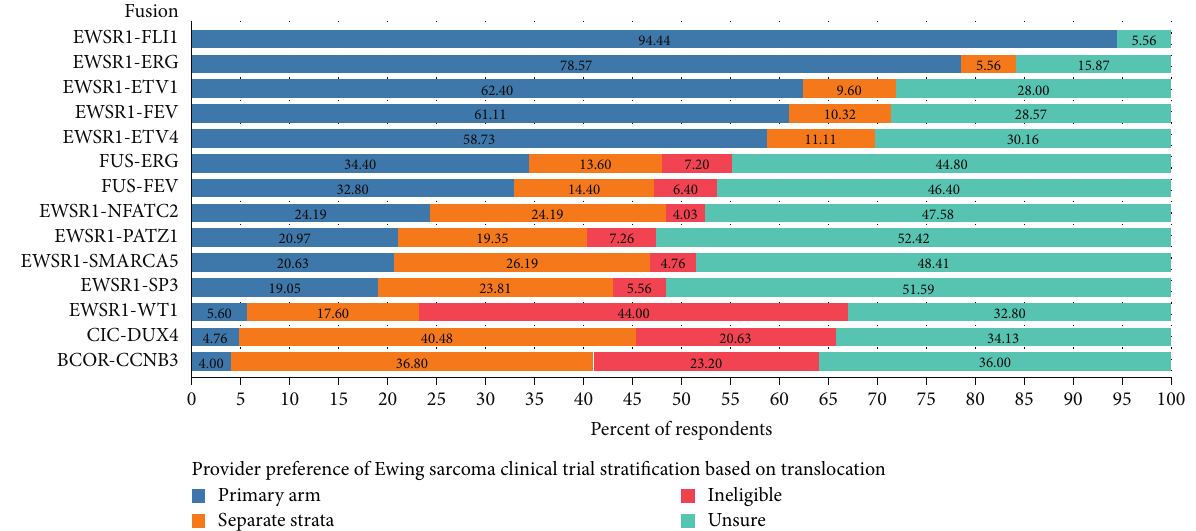
Figure 3: Perceptions of respondents on the optimal stratification of variant chromosomal translocations on future Ewing sarcoma clinical trials. The data represent the percentage of respondents who believed that a given translocation in the column on the left should result in inclusion in a Ewing sarcoma clinical trial in the primary stratum (blue bar and percentage), in a separate stratum (orange bar and percentage) or if the translocation makes a patient ineligible (red bar and percentage) for a Ewing sarcoma study. The teal bar and percentage indicate the number of respondents who were unsure of how the translocation should influence inclusion criteria.